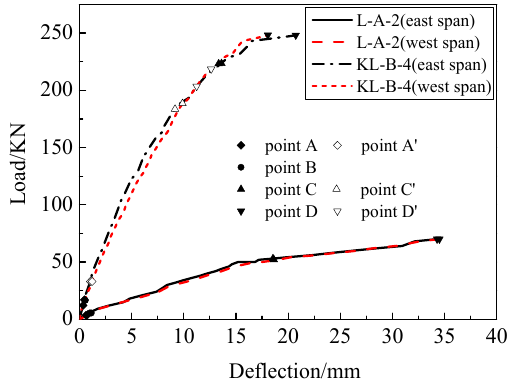
Figure 4. Load versus displacement curve.